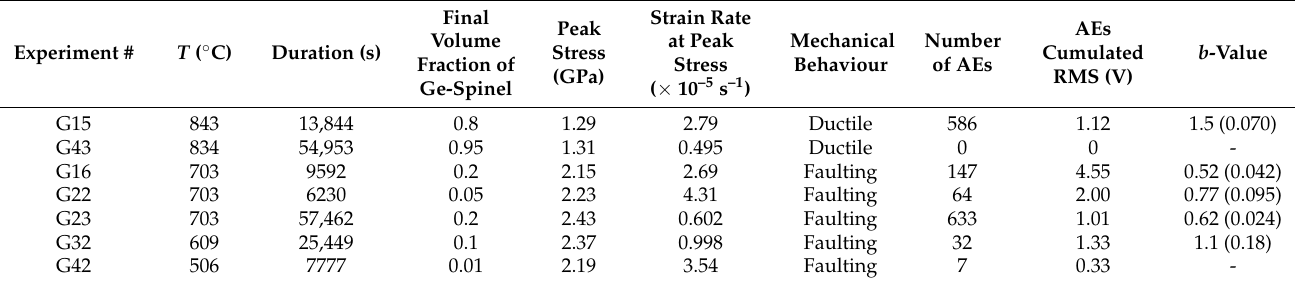
Table 1. Experimental conditions and results. Error on temperature is estimated to be ± 6.8% [24]. Standard deviation on obtained b -values is given between